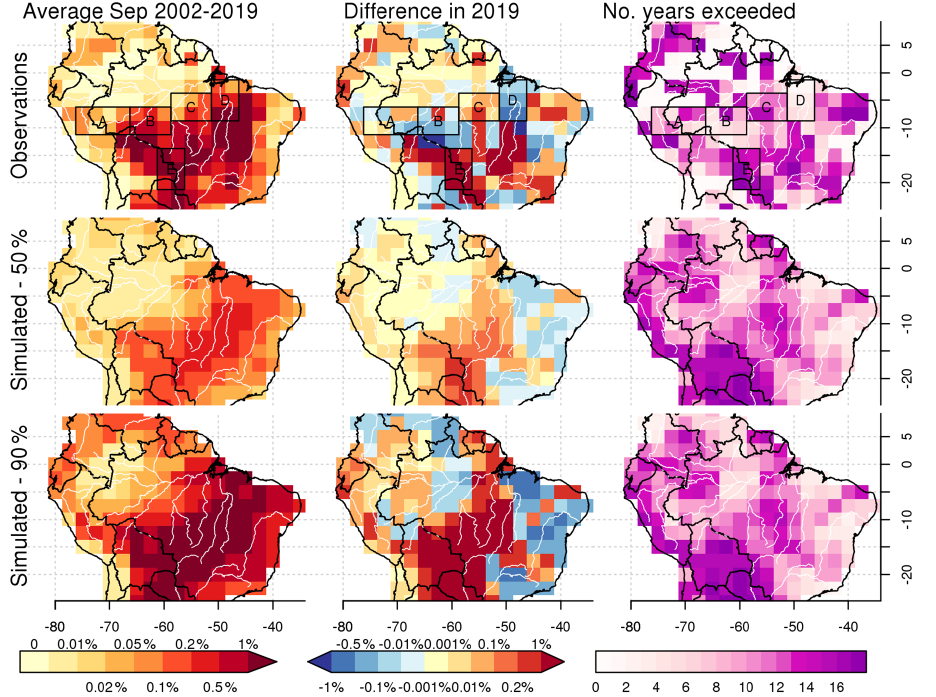
Figure 4. Same as Fig. 3 but for